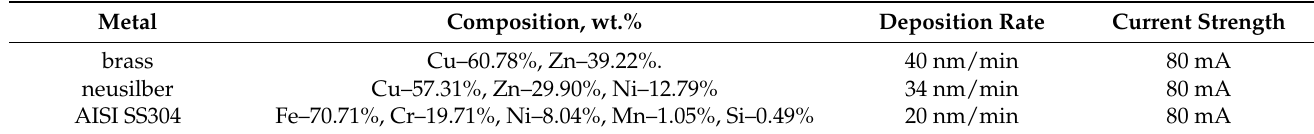
Table 1. Parameters of deposition of metal films on glass